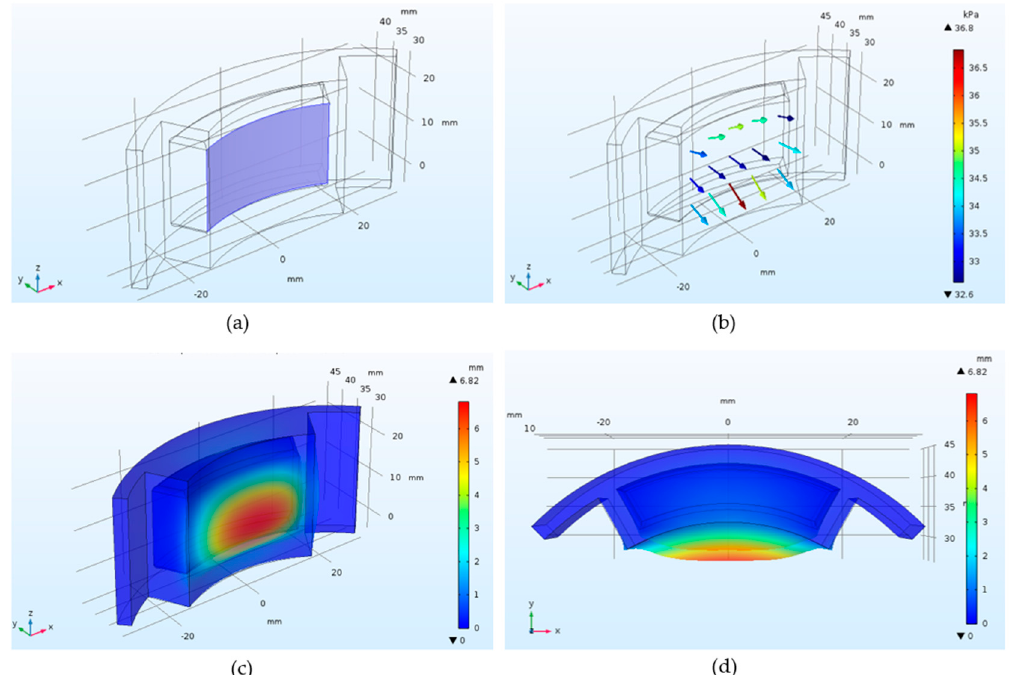
Figure 3. ( a ) Wireframe of single actuator with deformable surface highlighted in blue; ( b ) normal vectors on the expanding surface; ( c ) simulated model showing expansion of the principal active wall; and ( d ) top view of simulated model of single actuator with expansion of the principle active wall.